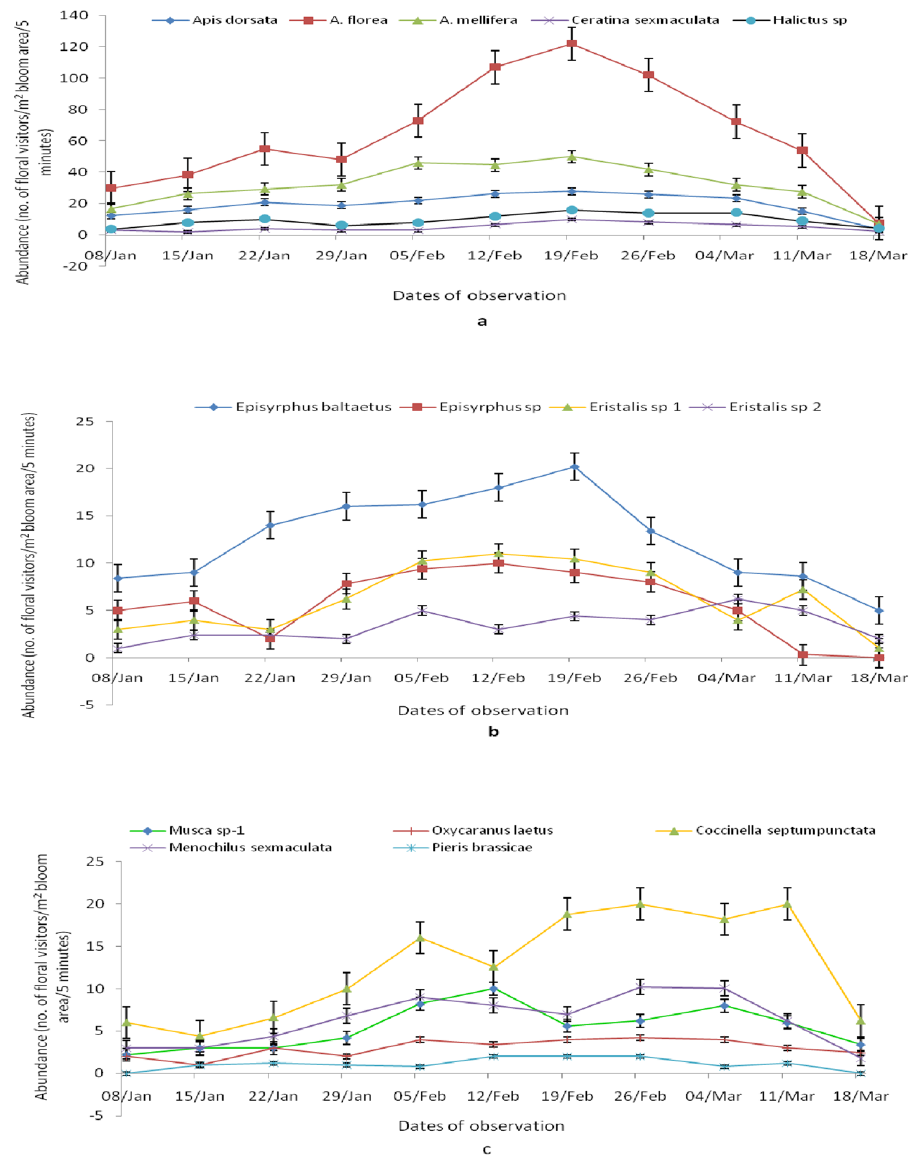
Figure 3. Fluctuation in populations (number of floral visitors/m 2 bloom area per 5 min) of ( a) bees, ( b) Syrphids, and ( c) other pollinators on dill seeds during flowering in semi-arid